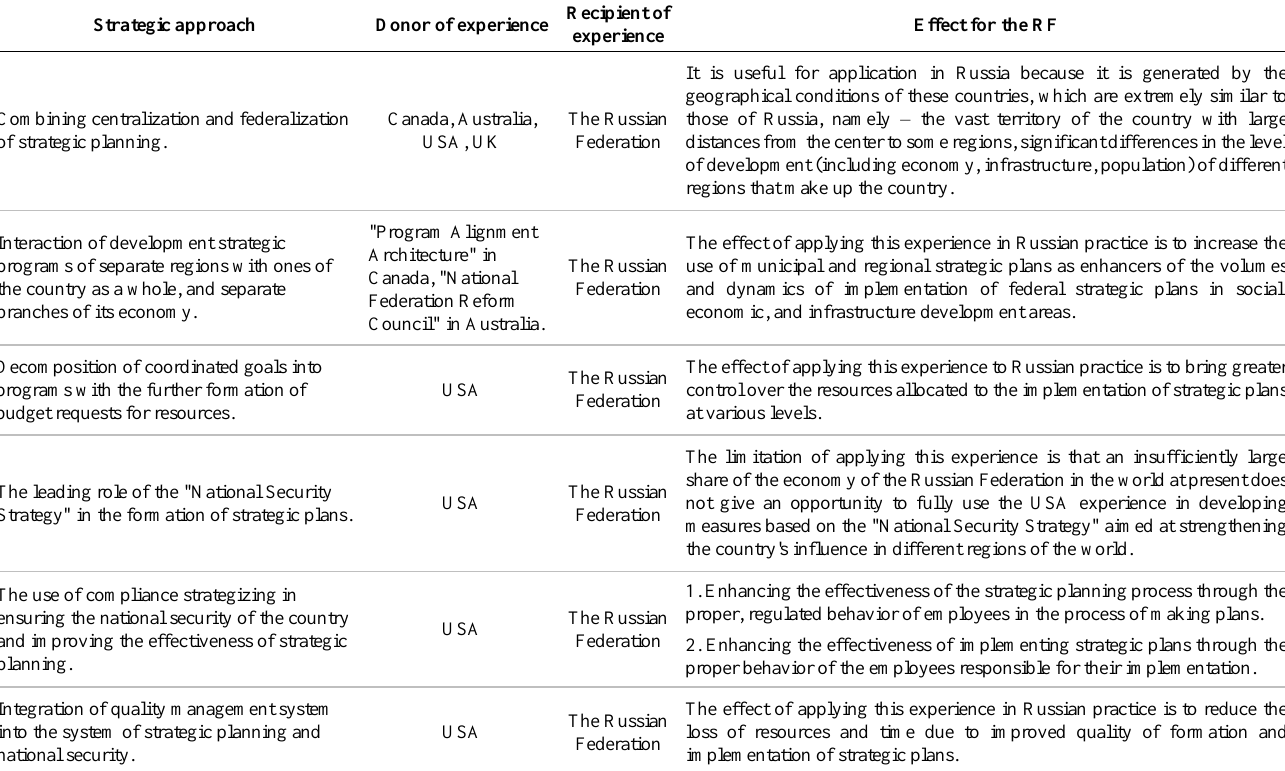
Table 1. Classification of the features of strategic planning within the international experience Strategic